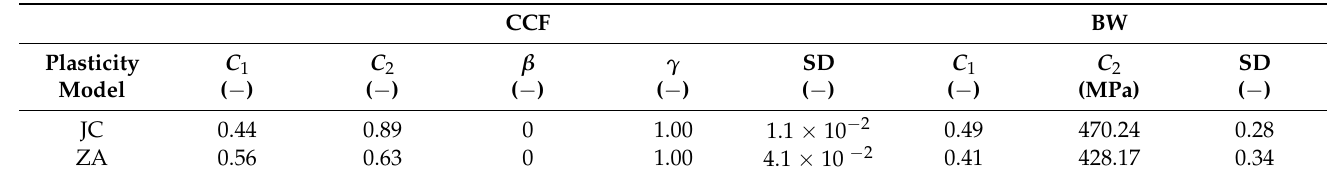
Table 6. Numerical results, ZA model: strain rate (𝜀(cid:4662)) , average 𝑇 and 𝑋 values; experimental strain at fracture ( 𝜀 (cid:3033) ), strain at fracture (𝜀 (cid:3033)(cid:3040)(cid:3042)(cid:3031)(cid:3032)(cid:3039) ) and relative error (RE) as predicted by the CCF and BW damage models.